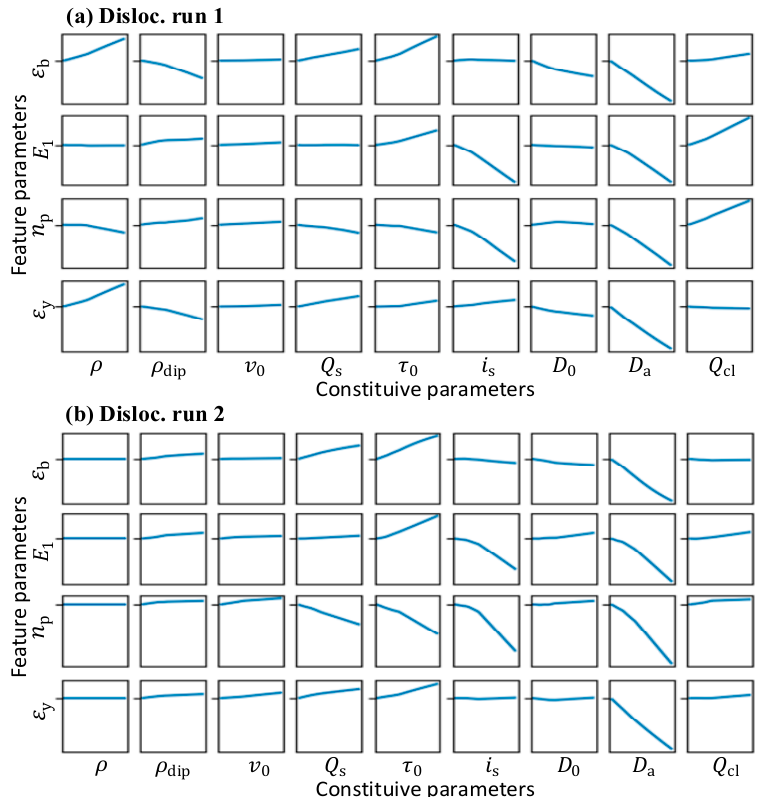
Figure 16. The integrated gradients for the BNN surrogate of dislocation-density-based CP model in ( a ) run 1 and ( b ) run 2.